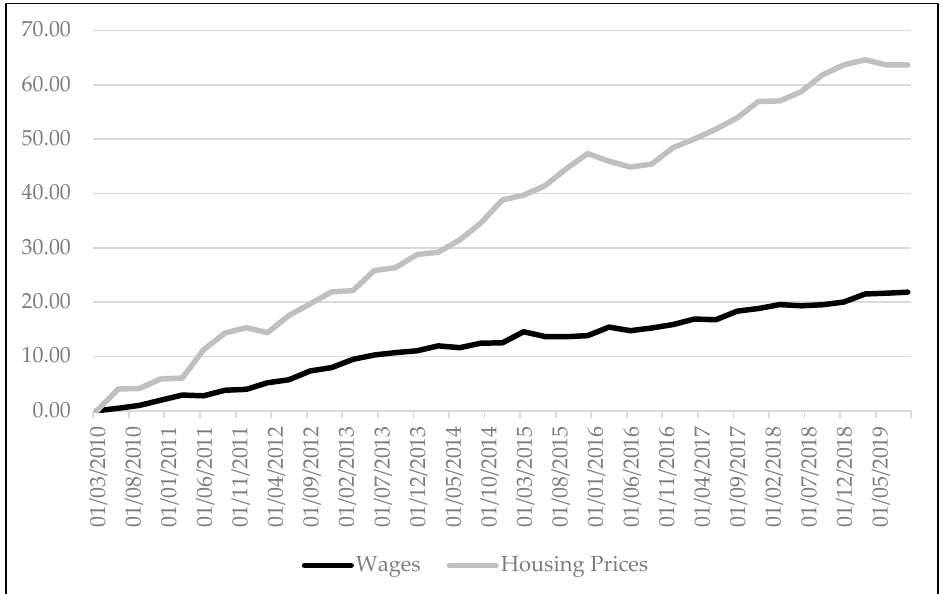
Figure 1. Real housing price index in Chile versus global compensation index. Source: authors elaboration using public data available from the Central Bank of Chile [8].